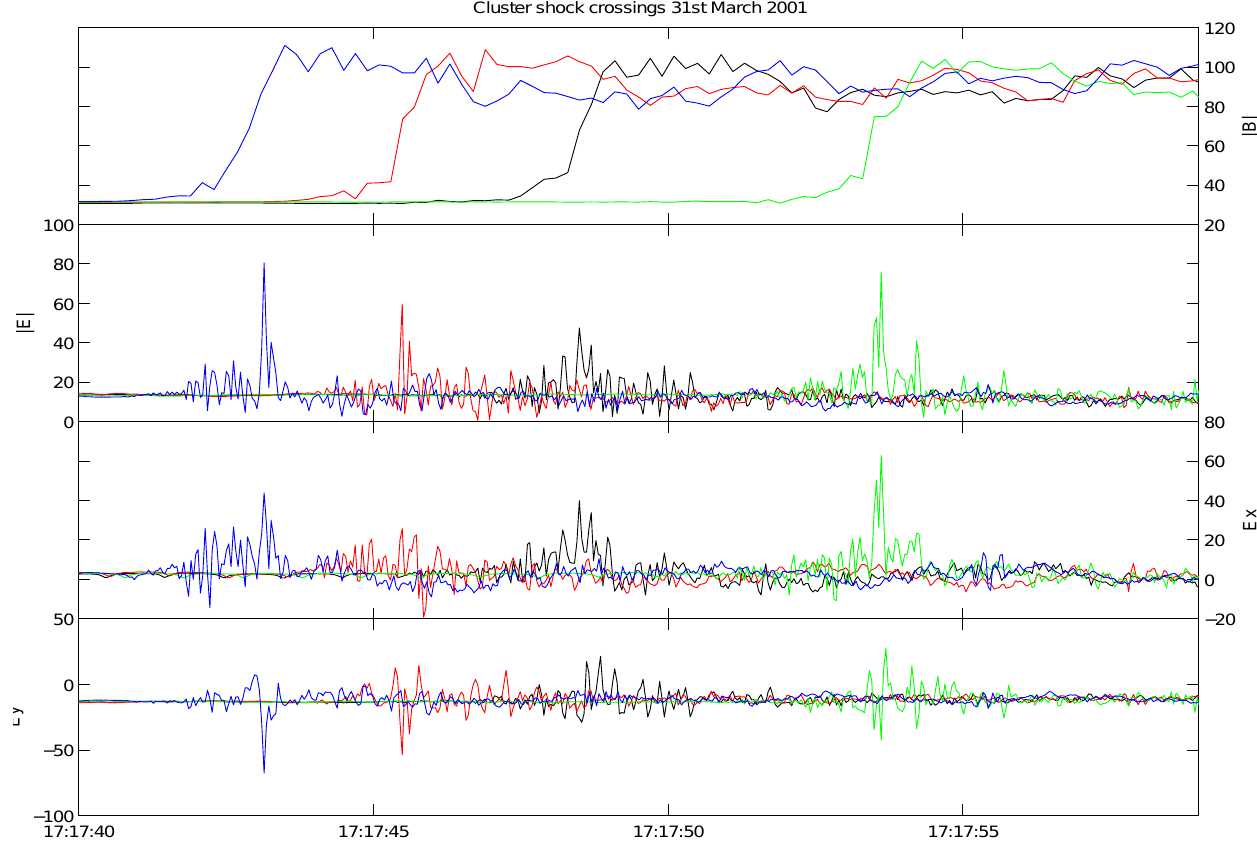
Fig. 3. Overview of the shock crossing on 31 March 2001 at 17:18 UT. The top panel shows the magnitude of the magnetic field measured by FGM. The second panel shows the magnitude of the electric field measured in the satellites spin plane. The lower two panels show the spin plane components E x and E y